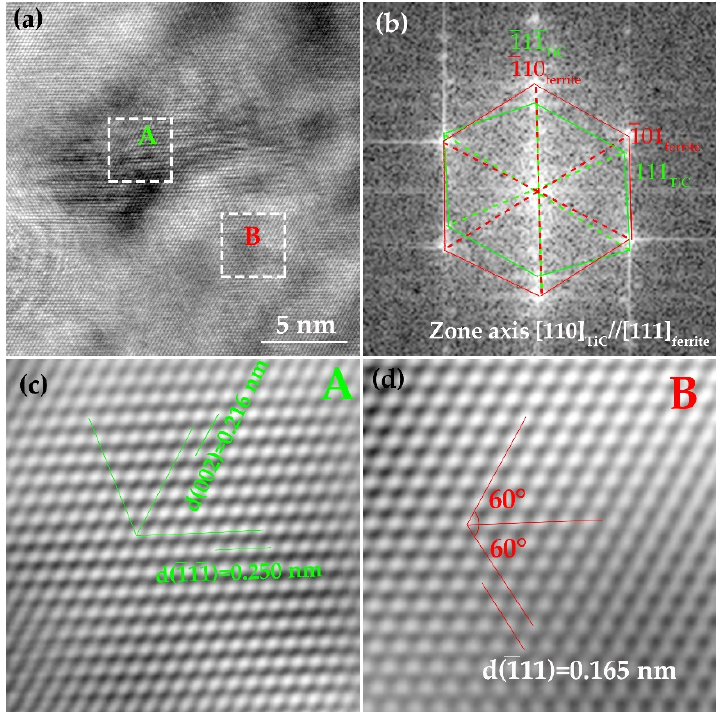
Figure 11. Crystallographic characterization of deformation-induced TiC formed in the mid- thickness of the plate in steel A. ( a ) HRTEM image; ( b ) FFT diffractogram; ( c , d ) IFFT of precipitate and matrix.